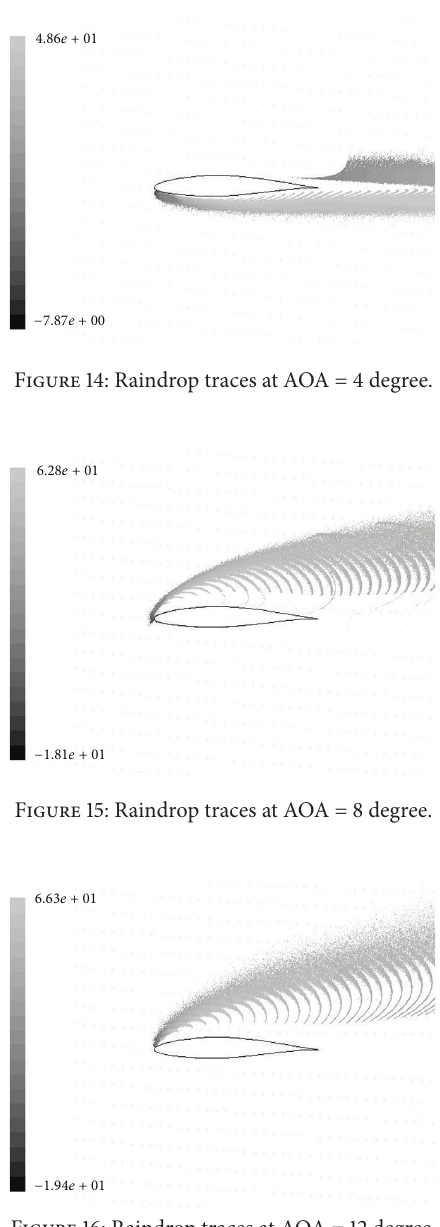
Figure 16: Raindrop traces at AOA = 12 degree.